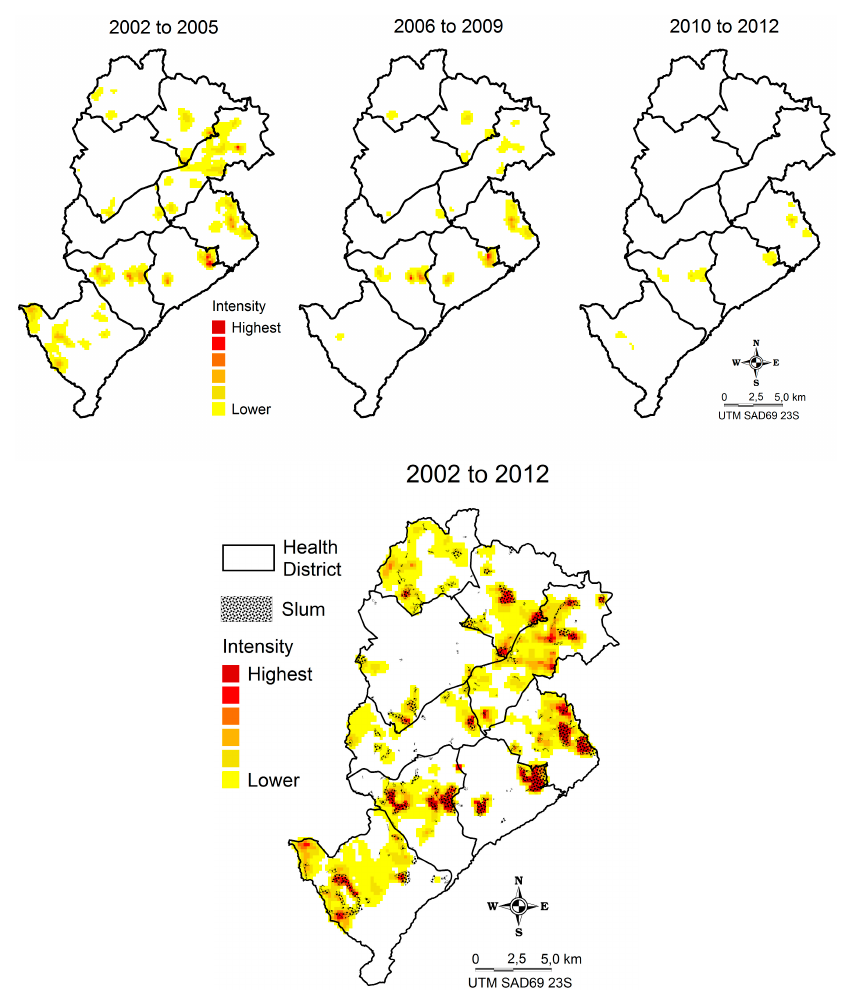
Figure 3. Frequency of asthma-related hospitalization in children and adolescents aged 0 ‒ 14 years in Belo Horizonte, Minas Gerais, Brazil, by residence address, 2002 ‒ 2012.